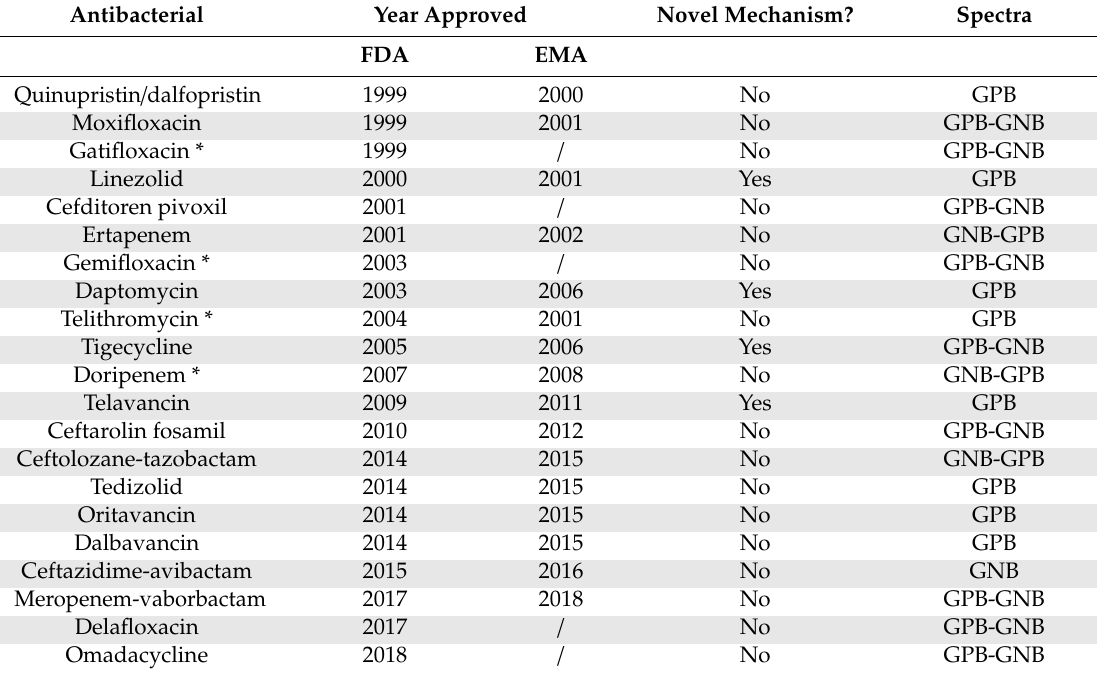
Meropenem-vaborbactam Delafloxacin